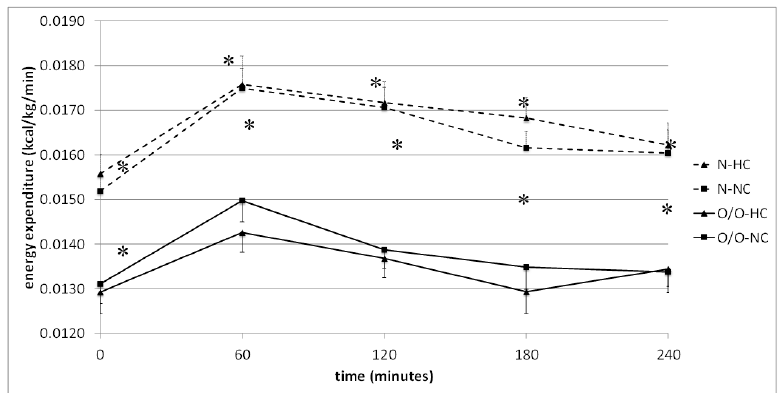
Figure 2. Energy expenditure (kcal/kg/min) in people with normal body weight (N, the broken line) and overweight/obese people (O/O, the solid line) in fasting state (time 0 min) and after consumption (time 60–240 min) of a high-carbohydrate meal (HC) and a normo-carbohydrate meal (NC). The results are presented as mean values ± SE. The comparison between study groups N and O/O * p < 0.05; the comparison between meals HC and NC.